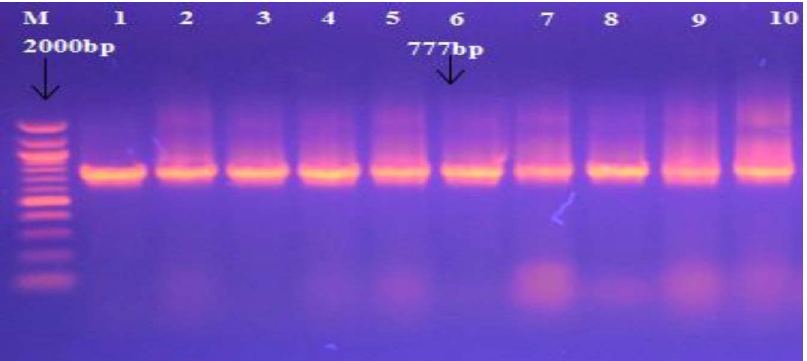
Fig. 2. Agarose gel electrophoresis and Genomic DNA isolated from S. aureus showing 16S rRNA gene for S. aureus using specific primer, with M: Marker (100-2000bp). All lanes were (1-10) positive PCR amplification at 777bp PCR product size.